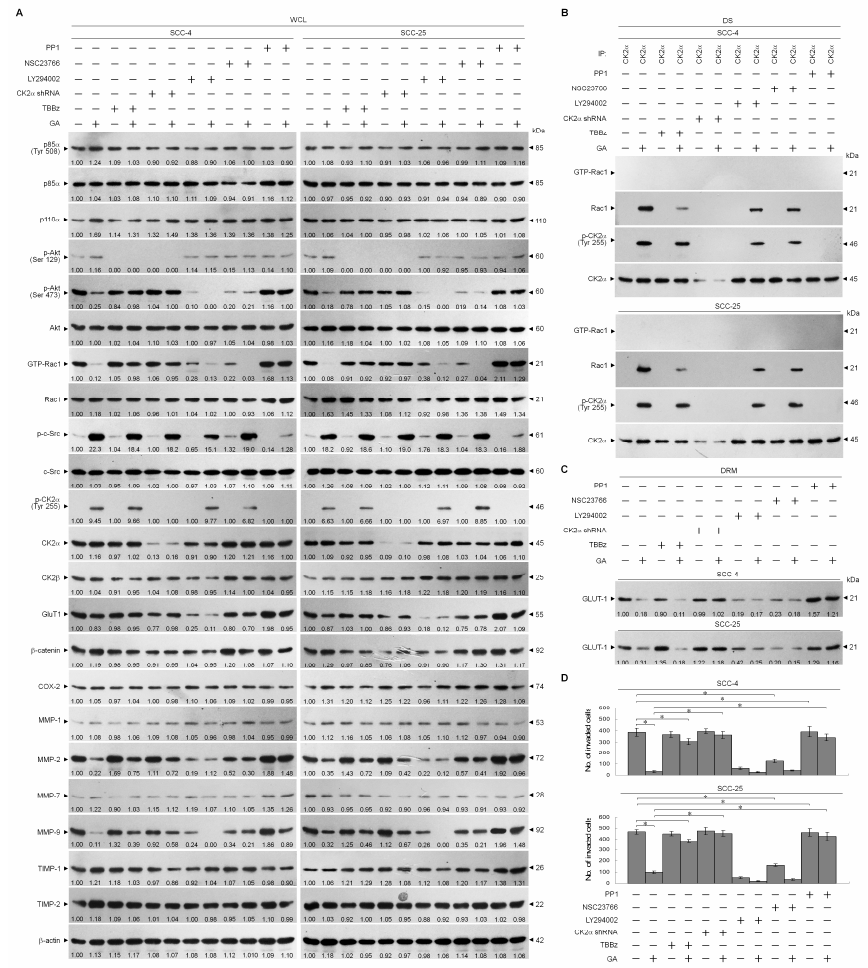
Figure 5. Formation of inactive Ras-related C3 botulinum toxin substrate 1 (Rac1)–phospho (p)-casein kinase 2 α (CK2 α ) (Tyr 255) complexes by gallic acid (GA)-induced cellular-Src (c-Src) activation causes the attenuation of protein kinase B (Akt)-mediated glucose transporter-1 (GLUT-1) lipid raft membrane-targeting, thereby inhibits matrix metalloproteinase-2 (MMP-2) / -9-mediated cell invasion. At 12 h after transfection with the CK2 α ShRNA or empty vector control, the cells were treated with vehicle ( − ), GA (20 µ M), 4,5,6,7-tetrabromo-1H-benzimidazole (TBBz) (12 µ M), GA (20 µ M) plus TBBz (12 µ M), 2-(4-morpho-linyl)-8-phenyl-4H-1-benzopyran-4-one (LY294002) (10 µ M), GA (20 µ M) plus LY294002 (10 µ M), N6-[2-[[4-(diethylamino)-1-methylbutyl]amino]- 6-methyl-4-pyrimidinyl]-2-methyl-4,6-quinolinediamine trihydrochloride (NSC23766) (50 µ M), GA (20 µ M) plus NSC23766 (50 µ M), 1-(1,1-dimethylethyl)-3-(4-methylphenyl)-1H-pyrazolo [3,4-d]pyrimidin-4-amin (PP1) (6 µ M), or GA (20 µ M) plus PP1 (6 µ M) for an additional 36 h. ( A ) The levels of the indicated proteins in the lysates of vehicle- or indicated compound-treated or CK2 α short hairpin RNA (shRNA)-transfected cells were determined by Western blot analysis using specific antibodies. β -Actin was used as an internal control for sample loading. ( B ) The CK2 α used for co-immunoprecipitation is indicated at the top of the figure. The anti-CK2 α immunoprecipitations from the detergent-soluble (DS) fractions were immunoblotted with indicated antibodies. ( C ) GLUT-1 level in the detergent-resistant membrane (DRM) fractions was immunoblotted with GLUT-1 antibody. ( D ) The invaded cell numbers were assessed by the Matrigel invasion assays. The values are presented as the means ± standard error (S.E.M.) of three independent experiments. * p < 0.05: significantly di ff erent from vehicle ( − ) or GA-treated cells. The values above the figures represent relative density of the bands normalized to β